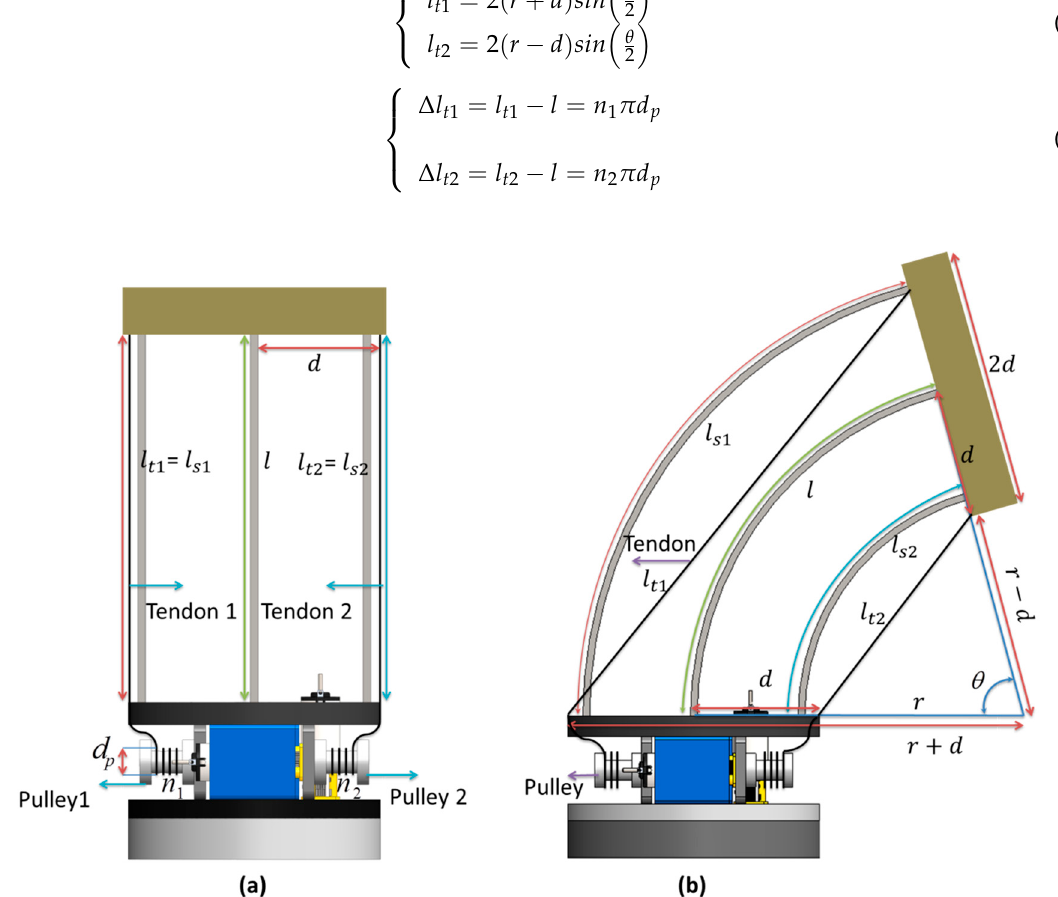
Figure 5. Actuator space modeling. ( a ) Module initial position at θ = 0 ◦ ; l = l t 1 = l t 2 = l s 1 = l s 2 . ( b ) Bending at θ ; r = radius of curvature, d p = diameter of the pulley, d = radius of the disk, l s 1 , l s 2 = lengths of the lateral springs, l t 1 , l t 2 = lengths of the tendons, n 1 = number of rotations of pulley 1, n 2 = number of rotations of pulley 2.